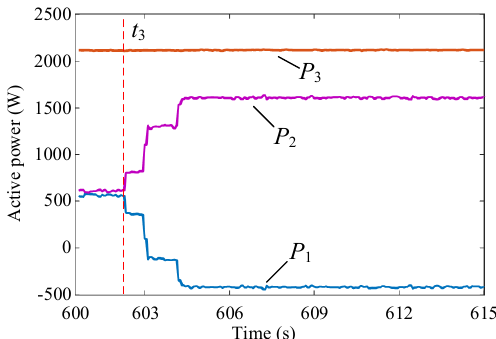
Figure 11. Active power waveforms of microgrid at Case